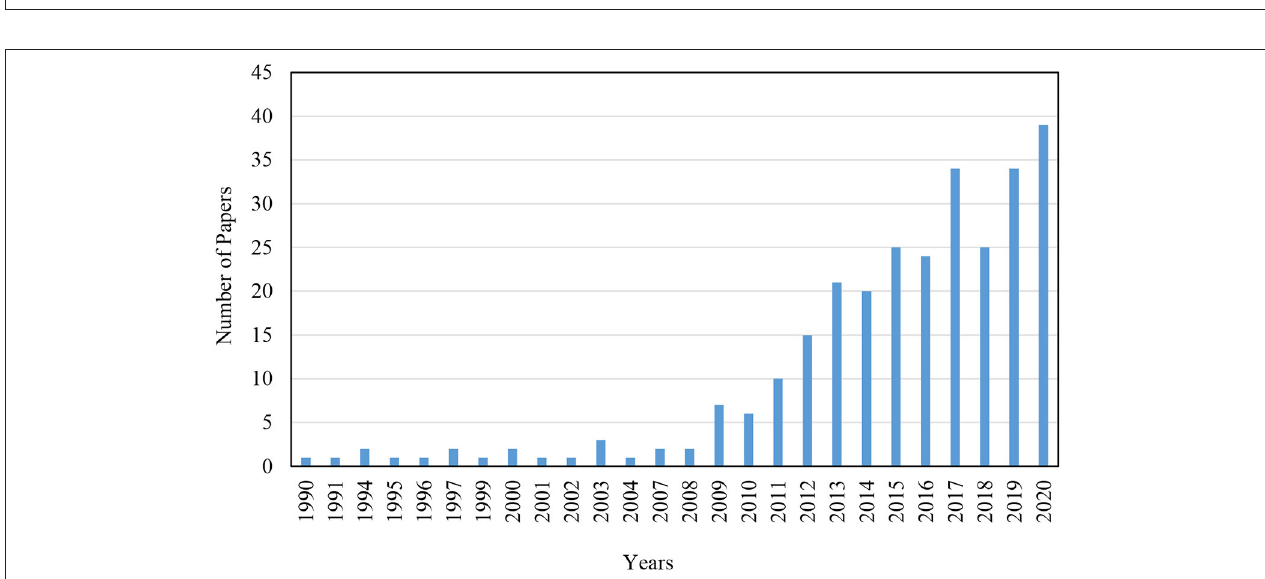
FIGURE 1 | Literature search and refining criteria for bibliometric analysis.